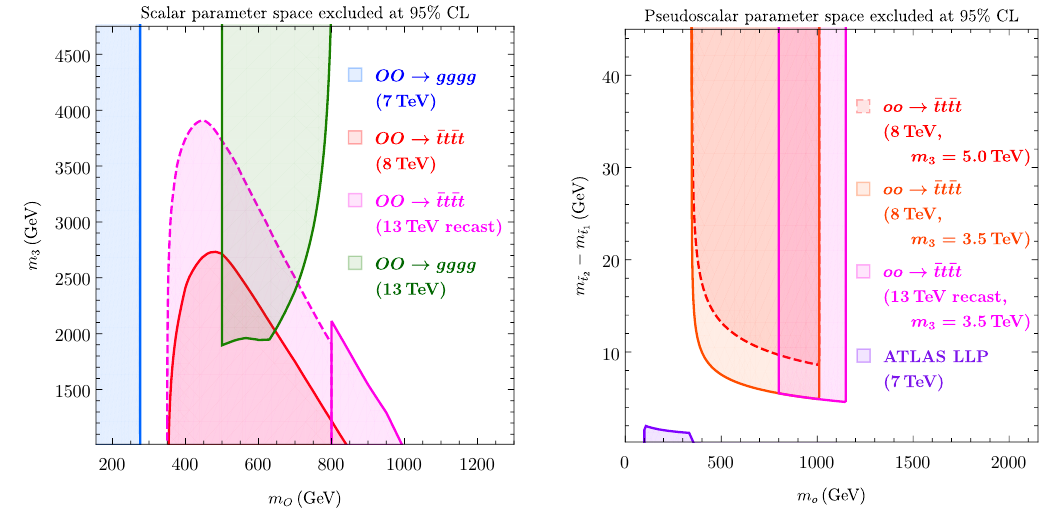
Figure 14. Excluded parameter space in (a, left) the ( m O , m 3 ) plane for the scalar, with all other parameters in benchmark B6, and (b, right) the ( m o , m ~ m ~ = 2.0 TeV and m 3 = 3.5 TeV or 5.0 t 1